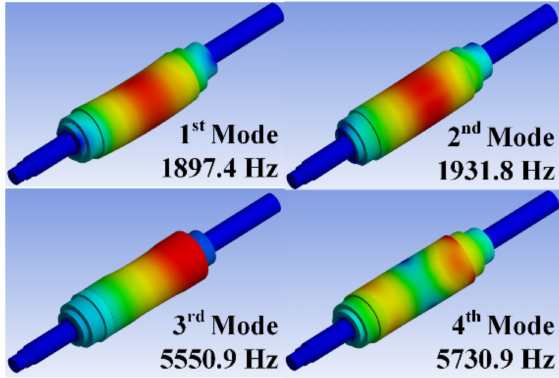
Figure 8. Modal analysis of Inconel 718 shaft